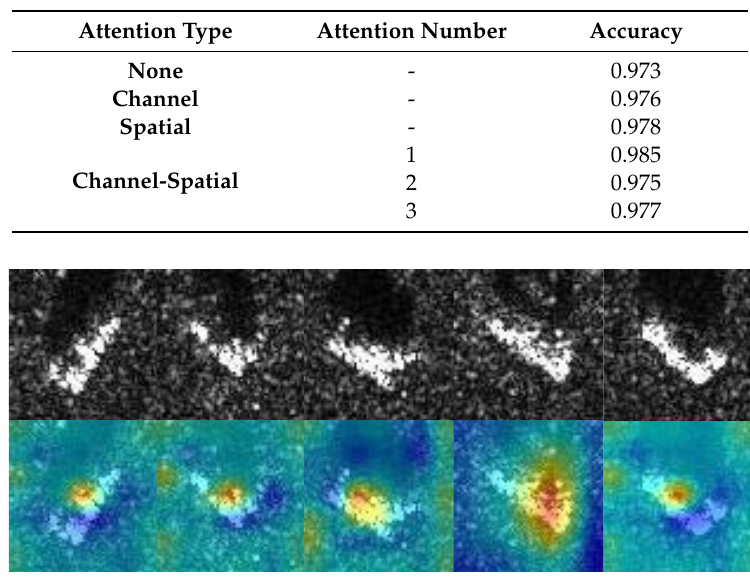
Figure 7. The attention maps of some instances.